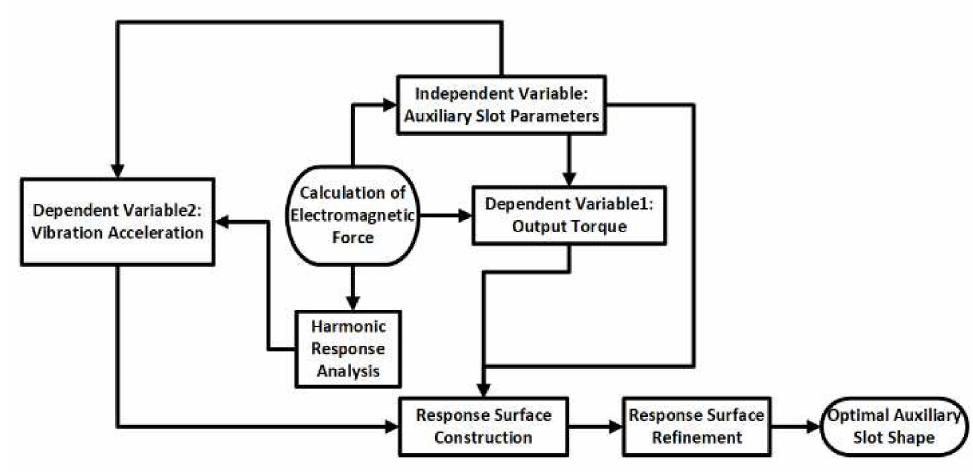
Figure 10. Optimization flow chart.